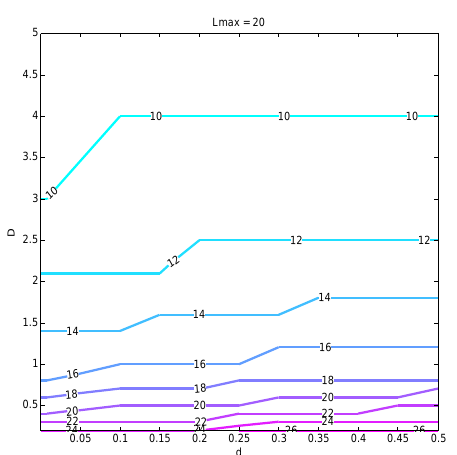
Fig. 3: Estimations of ˜ L max ( d,D )